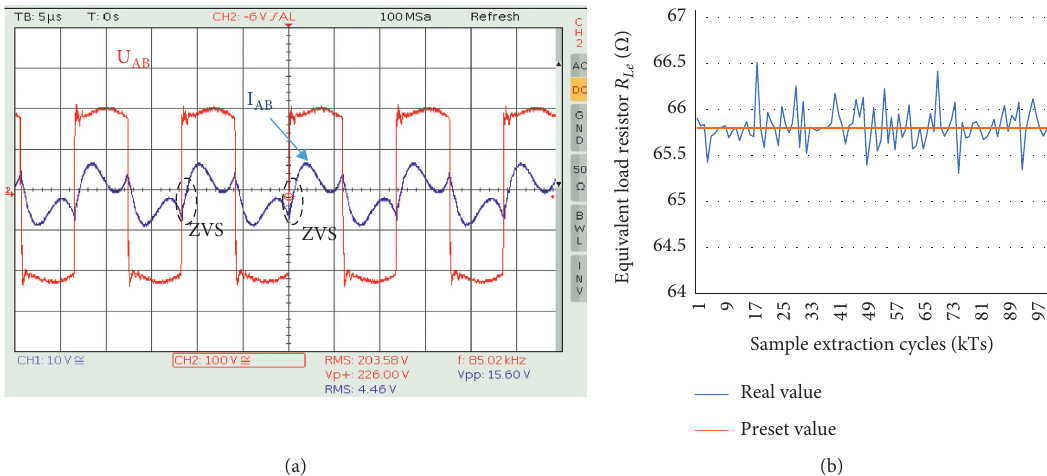
Figure 10: Experiment result at 0 mm position with no lateral misalignment. (a) Output voltage and output current of 85kHz inverter. (b) The measurement result of equivalent impedance R Le